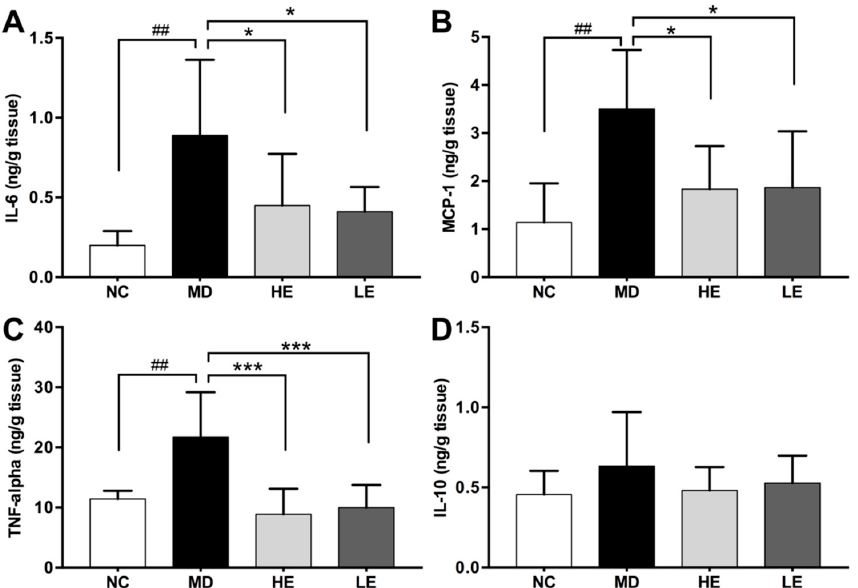
Figure 6. E ff ect of EGCG treatment on colonic tissue levels of inflammatory cytokines in DSS-induced colitis. At the end of the study, the colon was harvested and divided equally into three parts. Cytokine levels in homogenate of the proximal part of the colonic tissue were measured by ELISA. Pro-inflammatory cytokines IL-6 ( A ), MCP-1 ( B ), TNF-alpha ( C ) levels in the colonic tissue were significantly increased in DSS-induced colitis model while treatment with both high and low dose of EGCG significantly decreased them. No significant di ff erences were observed in the colonic tissue levels of IL-10 ( D ). IL-6: Interleukin 6, MCP-1: Monocyte chemoattractant protein-1, TNF-alpha: Tumor necrosis factor alpha, NC: Normal control group, MD: Colitis model group, HE: High-dose EGCG group, LE: Low-dose EGCG group. Data are presented as mean ± standard deviation. * p < 0.05 vs. MD, *** p < 0.001 vs. MD, ## p < 0.01 vs. NC. Treatment with EGCG inhibited the elevation of IL-6 (HE group: 0.45 ± 0.32 ng / g tissue, p = 0.03 vs. MD; LE group: 0.41 ± 0.15 ng / g tissue, p = 0.03 vs. MD, Figure 6A), MCP-1 (HE group: 1.83 ± 0.89 ng / g tissue, p = 0.01 vs. MD; LE group: 1.87 ± 1.17 ng / g tissue, p = 0.01 vs. MD, Figure 6B), and TNF-alpha (HE group: 8.87 ± 4.24 ng / g tissue, p < 0.001 vs. MD; LE group: 10 ± 3.76 ng / g tissue, p < 0.001